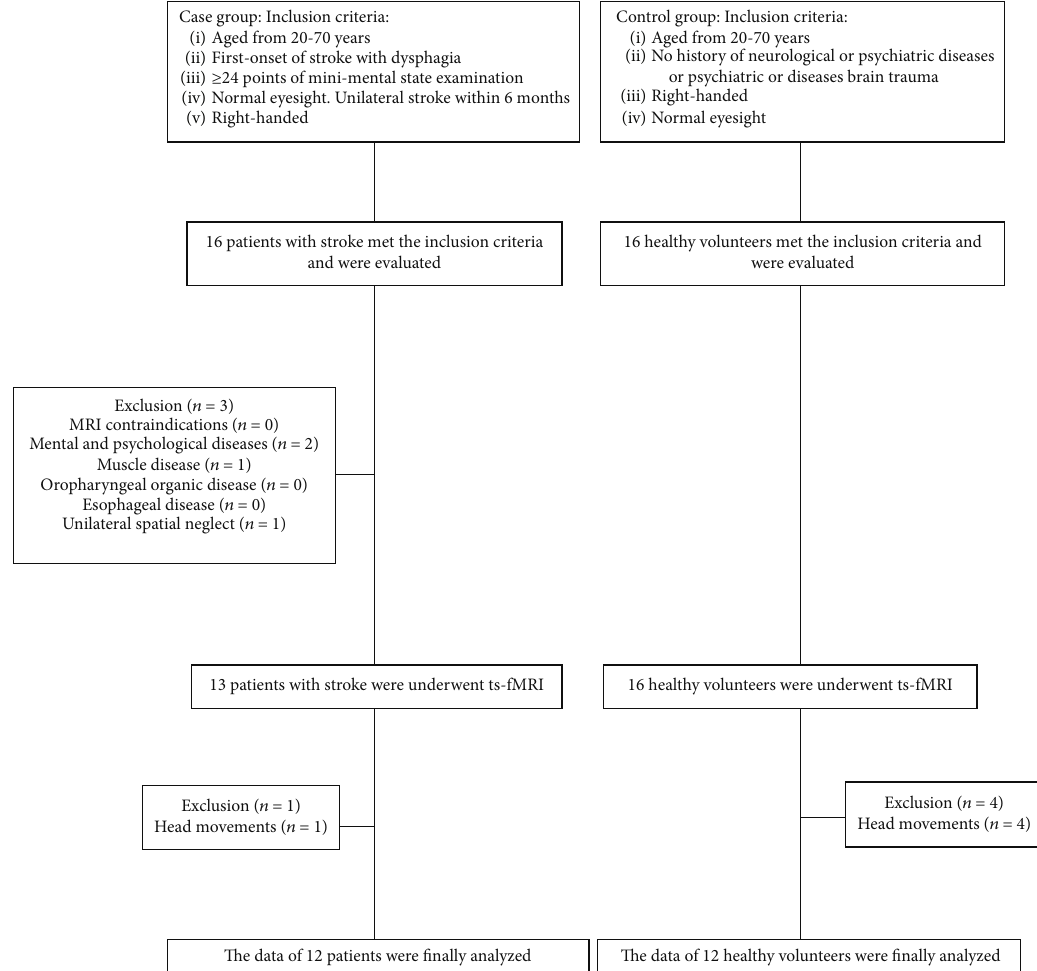
Figure 1: A schematic illustration of the participant selection process used in the present study.